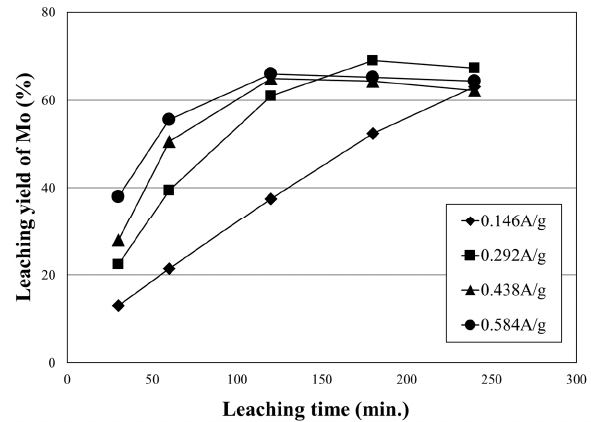
Figure 6. Leaching yields of molybdenum with time as a function of current density (pulp density: